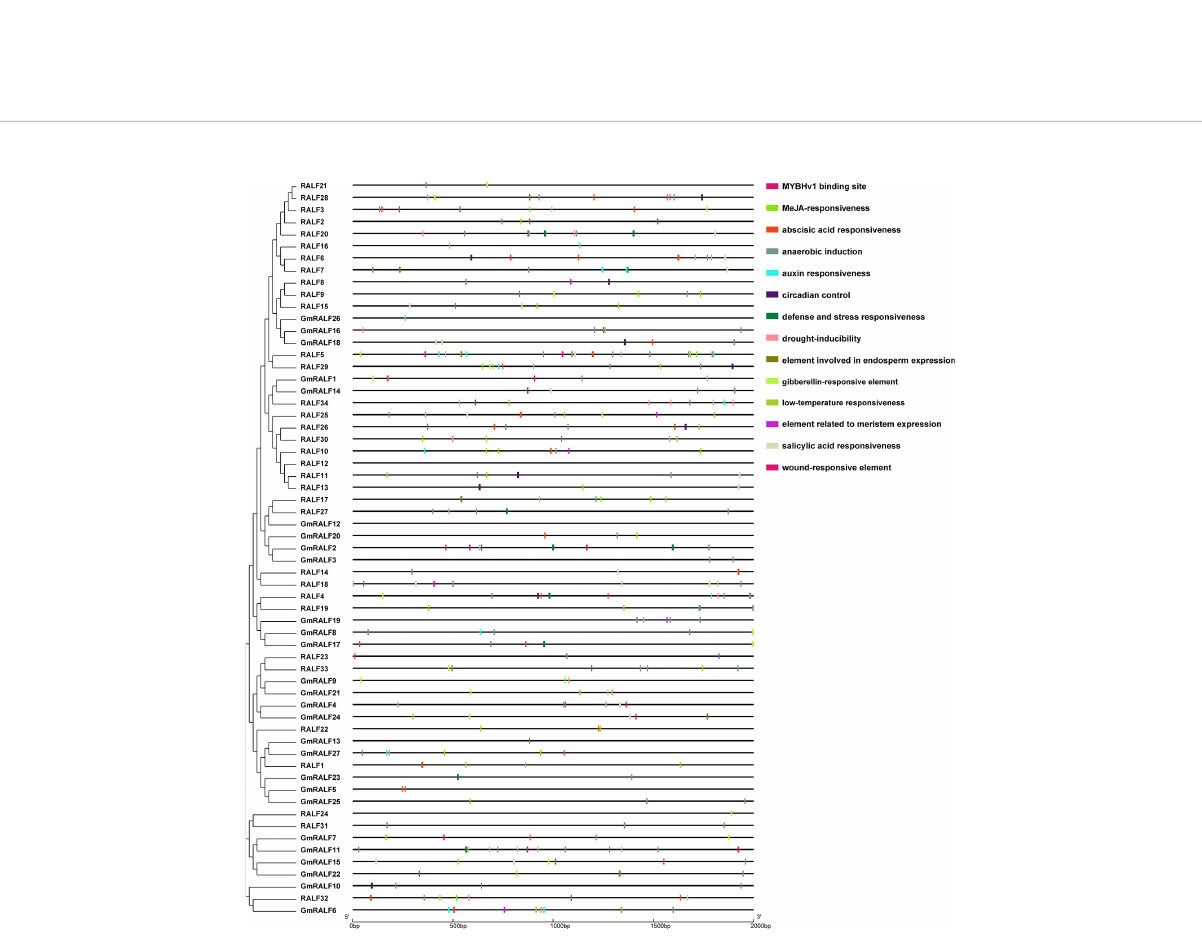
FIGURE 5 Cis -elements in the RALF promoter regions in soybean and Arabidopsis . Left panel: phylogenetic clustering of the GmRALF members. Right panel: the pattern of the cis -elements in the 2 kb upstream hereditary regions of the identi fi ed GmRALFs . Different cis -elements were indicated by distinct colored